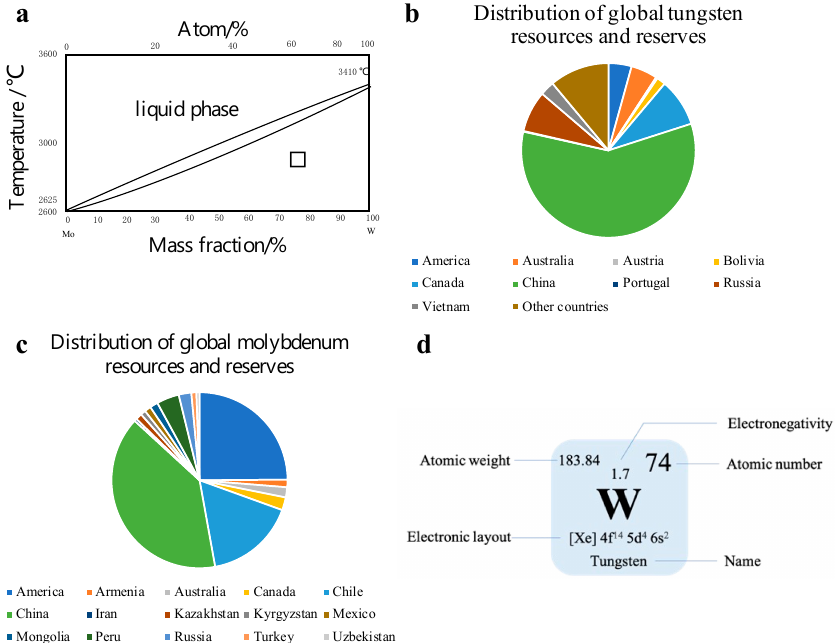
Figure 3. Advantages of tungsten ‐ based catalyst. ( a ) State diagram of W and Mo. ( b ) Distribution of global tungsten resources and reserves. ( c ) Distribution of global molybdenum resources and reserves. ( d ) Basic data of tungsten.